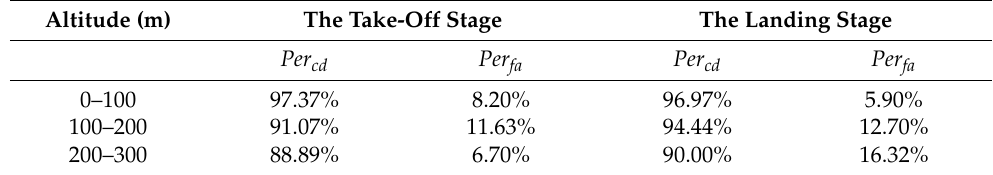
Table 7. Conflict prediction accuracy under different flight